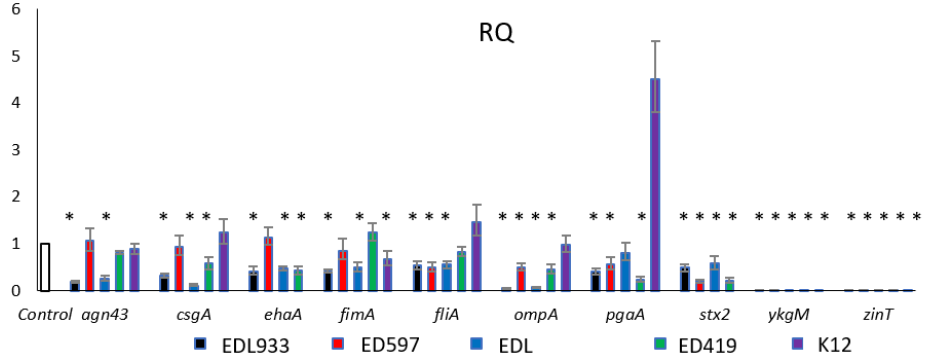
Figure 2. Expression levels of selected genes related to biofilm formation and pathogenesis in E. coli strains treated with or without C. martini EO at 0.05% ( v / v ) concentration. Transcriptional profiles were measured by qRT-PCR. * p < 0.01.